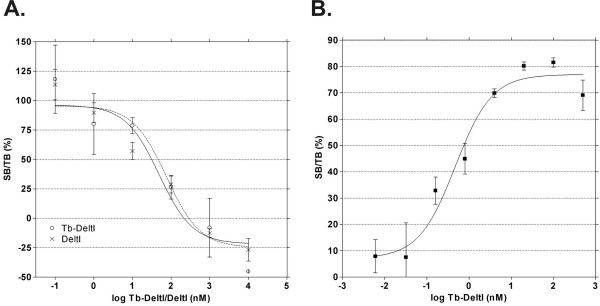
The binding of Tb-DeltI to CHO/MYChDOR -cells. A. Tb-DeltI can displace 3H-diprenorphine with similar affinity as unlabeled DeltI. In the competitive binding experiment 0.1 nM – 10 μM Tb-labeled DeltI or native DeltI was used to displace 6.86 nM3H-diprenorphine from the CHO/MYChDOR cell membranes. Tb-DeltI displaced the radioligand with a similar affinity as the unlabeled native DeltI. The solid line (curve fit) and the crosses represents the competitive binding for DeltI; the dashed line and the open circles for Tb-DeltI. The data is presented as the specific binding (SB) relative to the total binding (TB). The specific binding depicts the radioligand binding that can be displaced by the competing ligand (DeltI or Tb-DeltI). B. Tb-DeltI shows specific, saturable binding to DOR binding sites. The nonspecific binding of Tb-DeltI to CHO/MYChDOR -cells was determined in the presence of 1 μM DeltI. The binding of Tb-DeltI was saturable at a nanomolar range. The data is presented as the specific binding (SB) relative to the total binding (TB). The specific binding depicts the binding of Tb-DeltI that can be displaced by the unlabeled ligand.